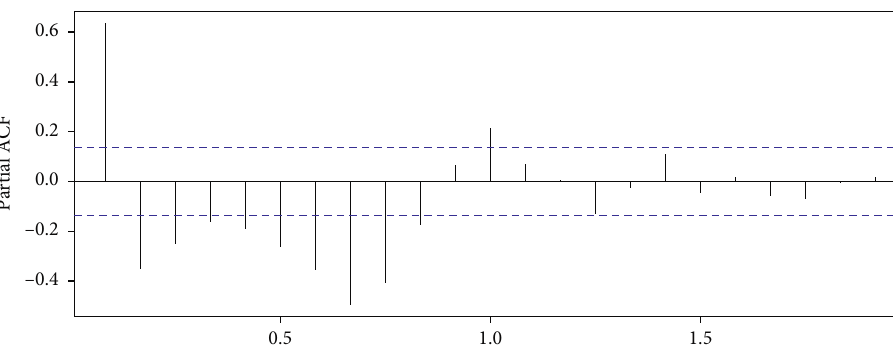
Figure 9: The partial autocorrelation diagram of SCST in region 13